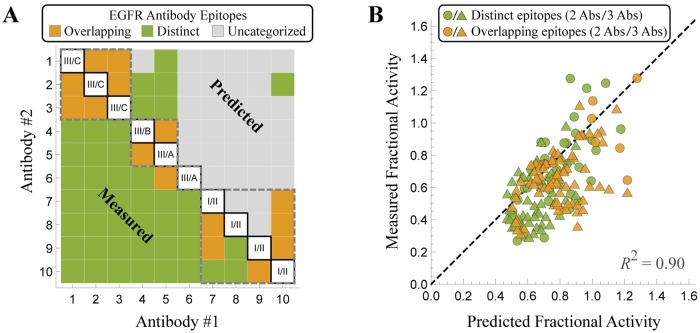
Classifying antibody epitopes as overlapping or distinct.(A) Comparing the experimentally measured activity to the overlapping or distinct epitope models enables us to characterize each antibody pair (provided the two models predict sufficiently different activities). The dashed squares represent the minimal epitope groupings inferred from this method. (B) The resulting predictions for the 2-Ab and 3-Ab mixtures have the same predictive power (R2 = 0.90) as a model that relies on epitope groupings given by SPR measurements (Fig 2B).